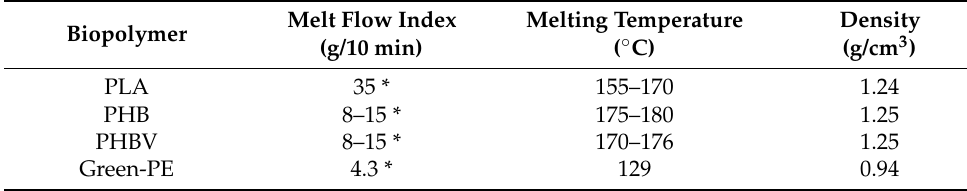
Table 1. Physical properties of biopolymers. Melt Flow Biopolymer